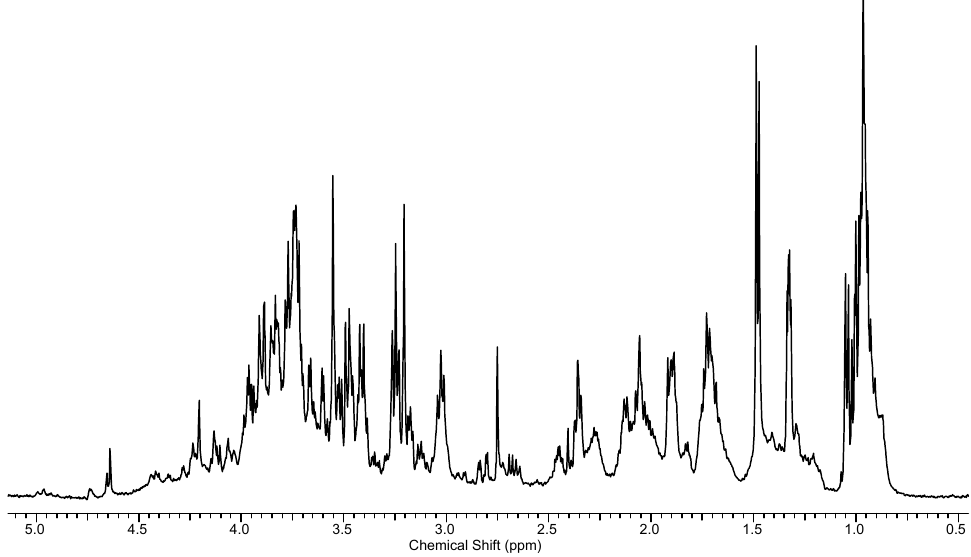
Figure 1. Nuclear magnetic resonance spectroscopy (NMR) of aqueous metabolites extracted from a sample of Daphnia magna . Complex overlapping peaks can be observed even in a shift range of just 0.5–5 ppm.